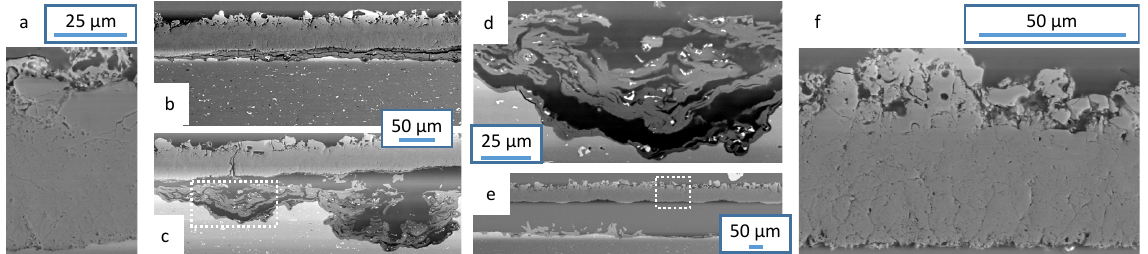
Figure 11. Backscatter SEM images of a sample which was exposed to electrolyte III at cross-sections of the unaffected ( a ) and affected region ( f ), as well at the transition zone between these areas ( b – e ).